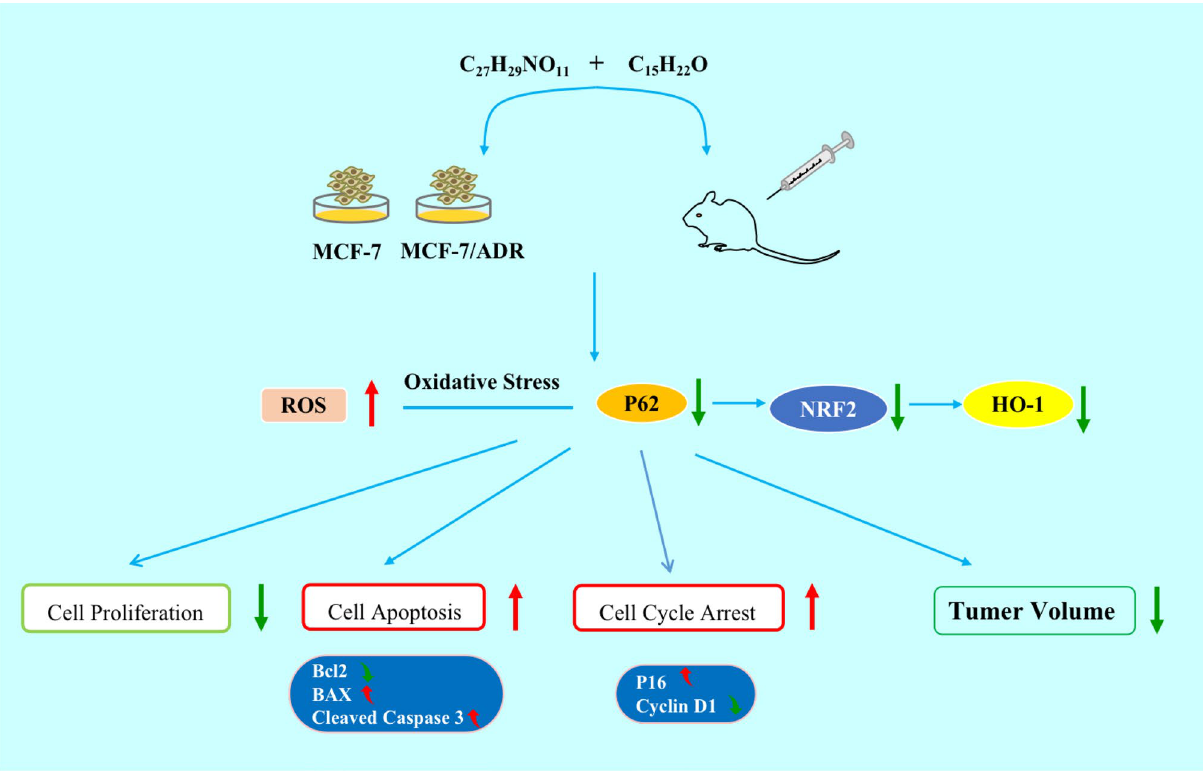
Figure 7. A schematic diagram of the effect of ADR + CYT combination on MCF-7 and MCF-7/ADR cells and their tumor bearing nude